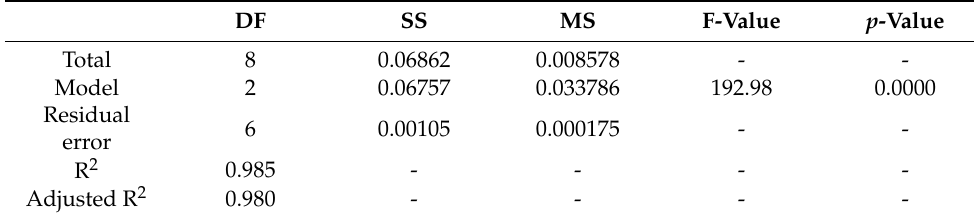
Table 4. Values of regression coefficients of G F .